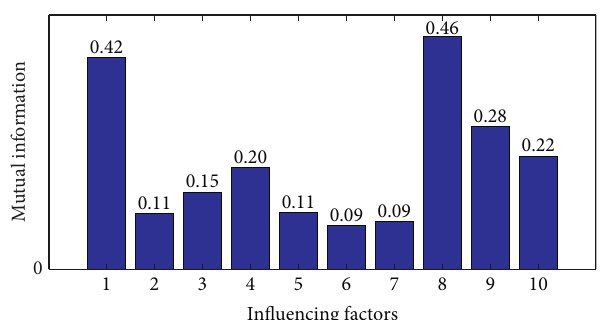
Figure 2: Preliminary analysis of feature relevancy with mutual